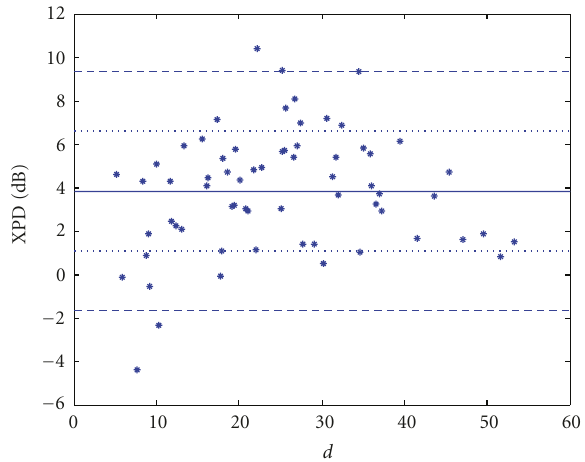
Figure 7: XPD in logarithmic scale, as a function of the Tx distance, in the indoor-to-indoor scenario with an initial vertical polarization.